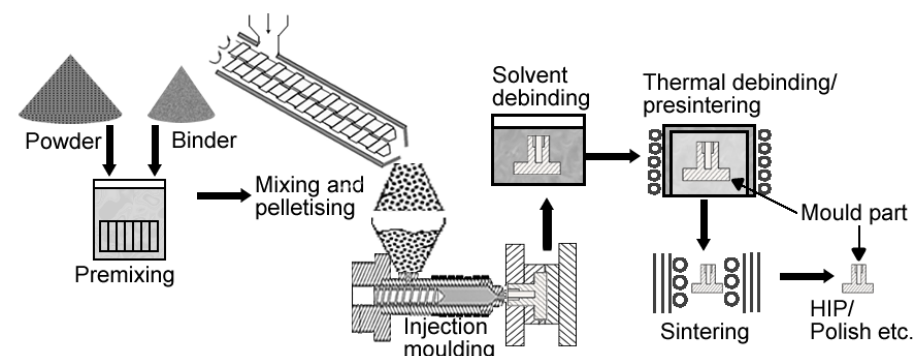
Figure 5. Metal injection moulding flow